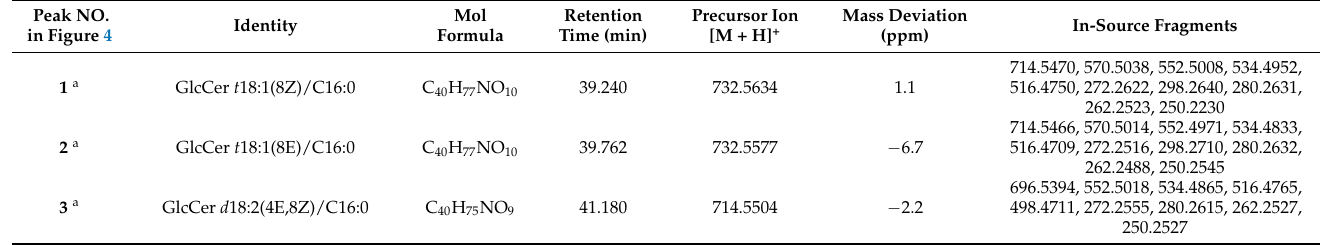
Figure 3. Proposed MS fragmentation scheme for GlcCer species compound 13 .